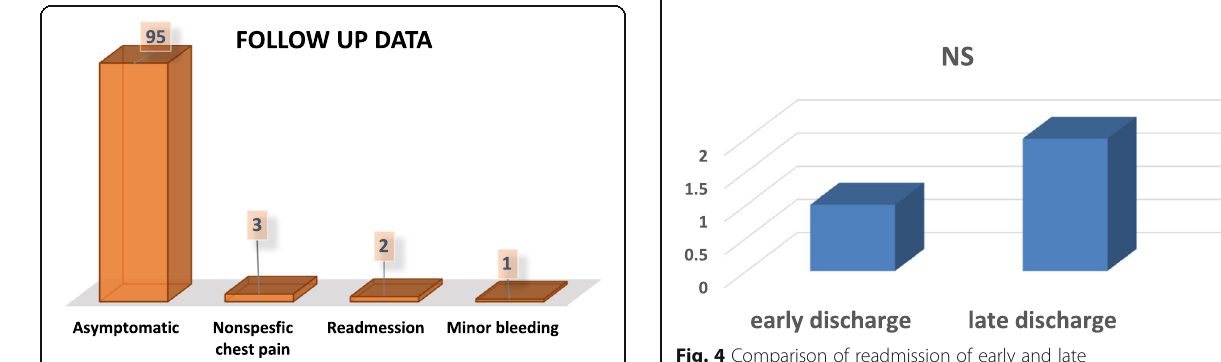
Fig. 3 Follow-up data of early discharged patients